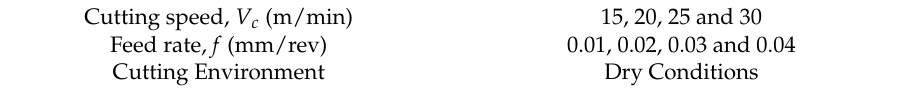
Table 2. Cutting conditions used in the drilling of CFRP laminates.